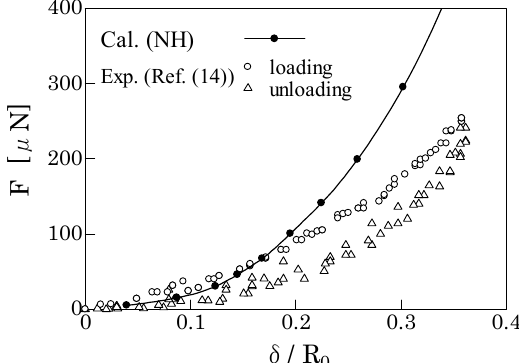
Fig.4 Comparison of calculated and experimental